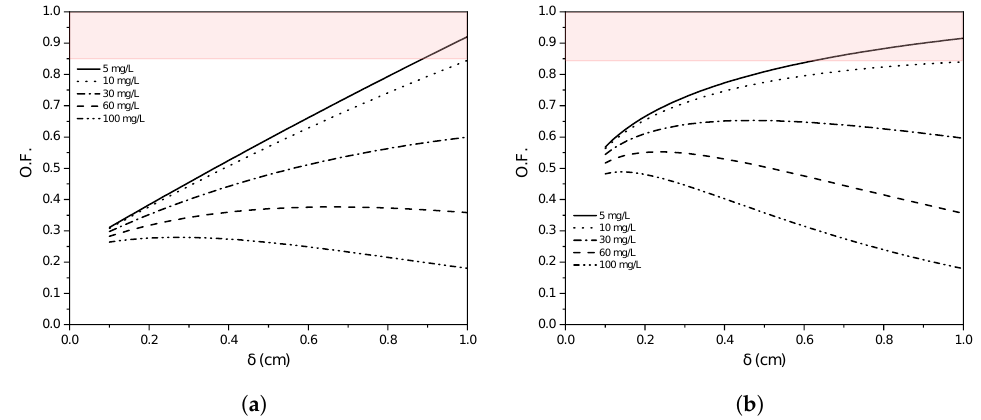
Figure 13. Objective function using WME in ( a ) laminar and ( b ) turbulent